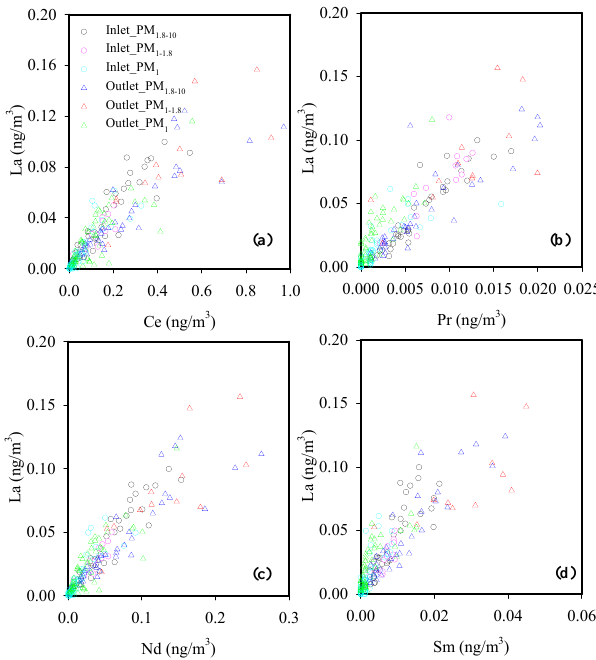
Figure 5. Scatterplots of La and (a) Ce, (b) Pr, (c) Nd, and (d) Sm concentrations (ngm − 3 ) in different size-segregated particles observed in Hsuehshan